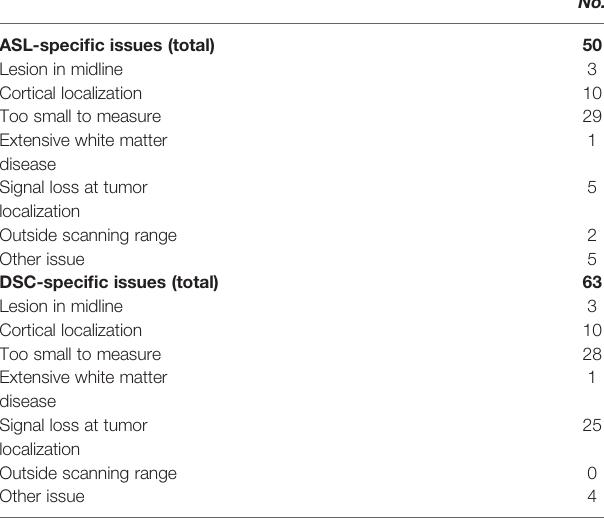
TABLE 2 | Lesion-speci fi c issues.